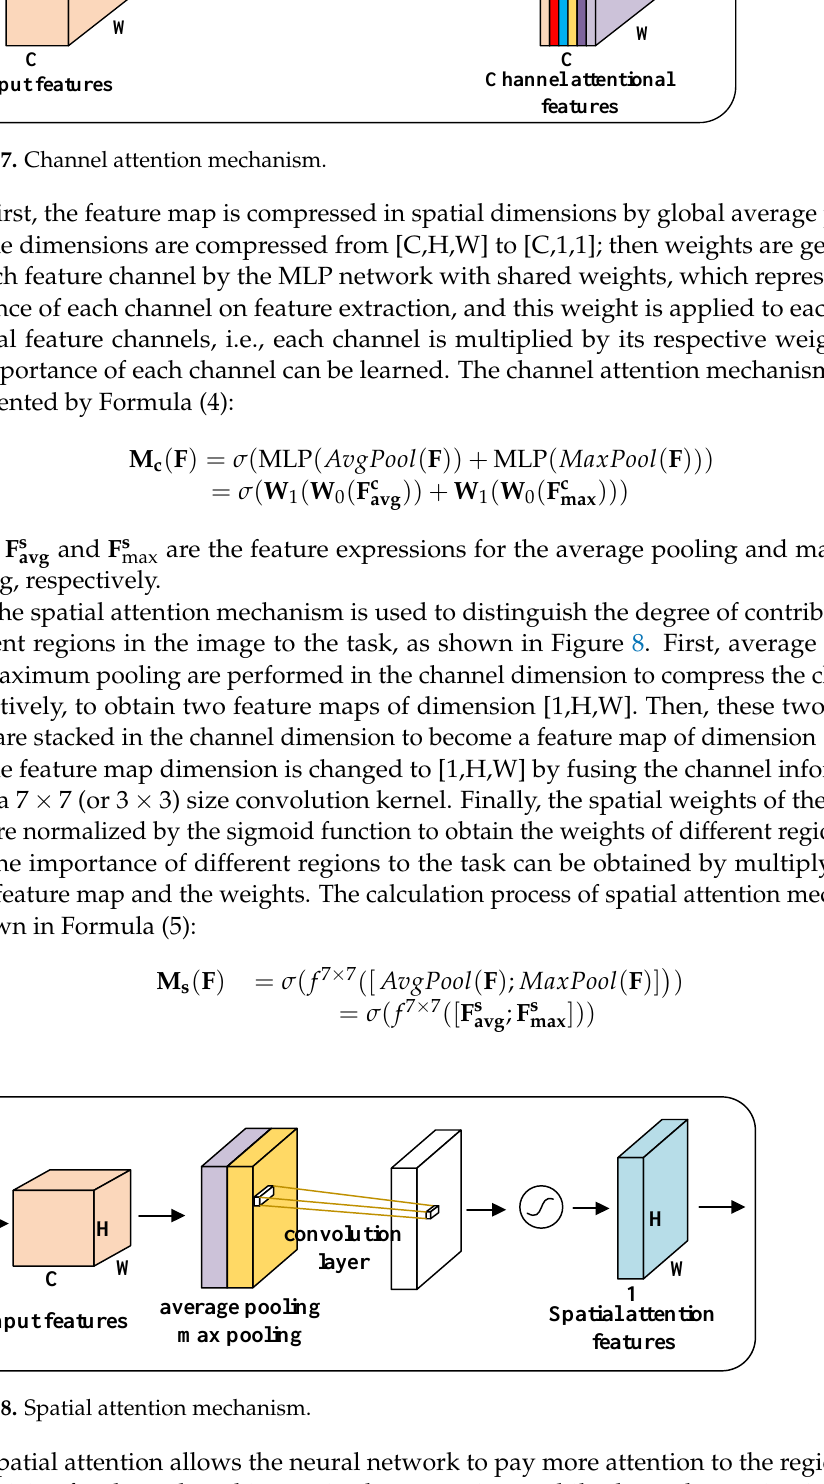
R e f i n e d F e a t u re s Figure 9. Convergence channel and spatial attention mechanism. 4. Grasping Quality Classification Network Incorporating Attention Mechanism Given the excellent point cloud classification performance, PointNet can be applied to evaluate grasping performance. The point cloud attention mechanism is added to make the network better extract the local point cloud that the classification task focuses on and to improve the network ’s accuracy. This section describes the specific structure of the point cloud classification network for grasp quality evaluation, designs the point cloud attention mechanism and finally proposes the PointNet grasp quality classification net- work incorporating the attention mechanism. 4.1. Structure Design of Point Cloud Classification Network Based on the analysis in Section 3.1, before feature extraction, PointNet learns a 3 3  transformation matrix through the T-Net network, multiplies it with the input point cloud and performs alignment operations on the input point cloud. The structure of the T-Net network is shown in Figure 10. The input point cloud data are treated as an 31 n  sin- gle-channel image, and after three times of convolution and one pooling, reshaping is to 1024 nodes, then two fully connected layers are connected and finally the output is recon- structed into a k k  matrix. The ReLU activation function and batch normalization are used for all but the last layer of the network. For the input transform, 3 k = .